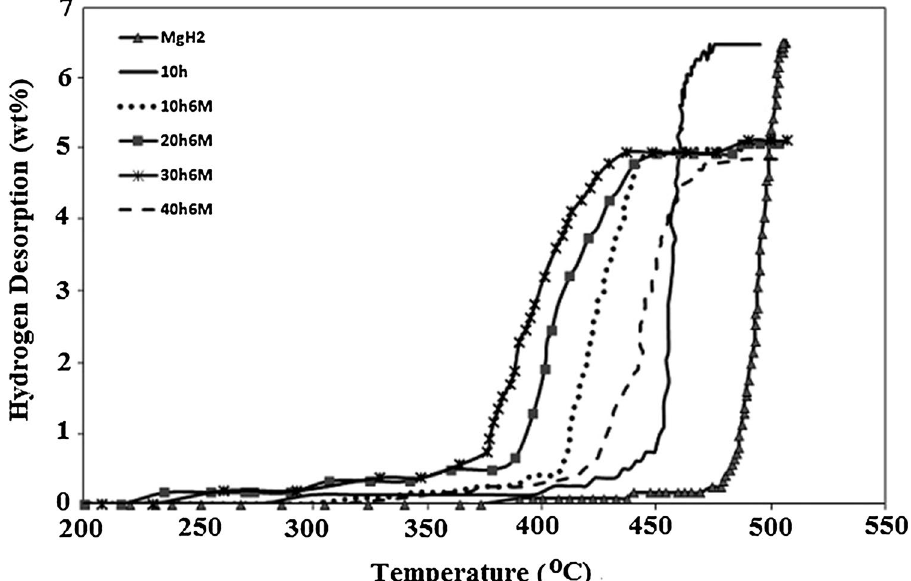
Fig. 10 Hydrogen desorption behavior of as-received MgH 2 , 10 h ball-milled MgH 2 , and MgH 2 -6 wt% of mischmetal ball-milled for 10, 20, 30, and 40